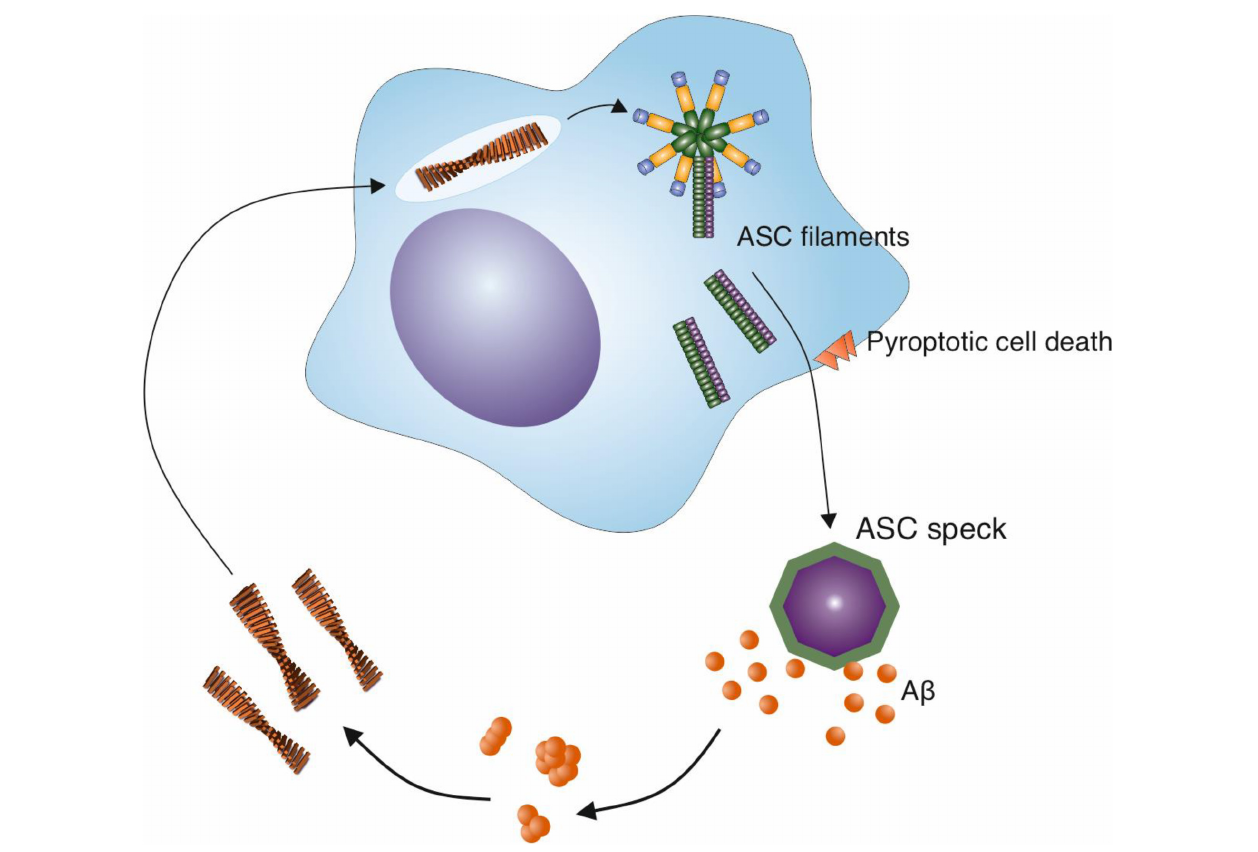
FIGURE 3 | ASC specks released from activated microglia cross-seed A β aggregation. The NLRP3 inflammasome is activated in microglia in response to a variety of stimuli, including A β fibrils. This activation leads to the release of specks formed from ASC, an adaptor protein that is involved in the inflammasome pathway. ASC specks cross-seed A β peptide, resulting in the formation of further A β aggregates in the brain and may create a cycle of inflammasome activation and amyloid